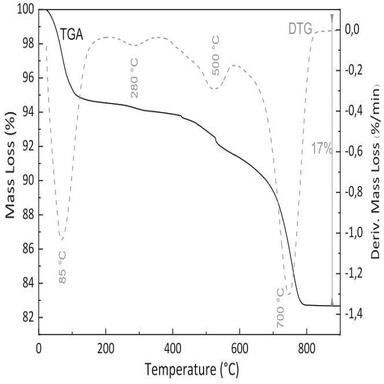
TG-DTG pattern of clayey sample.